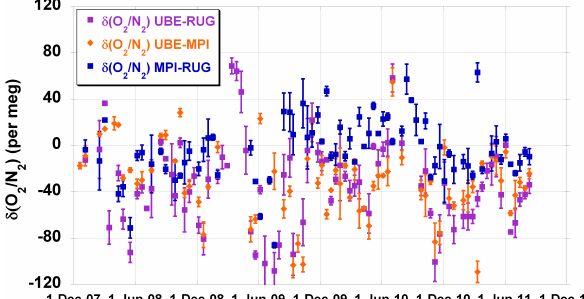
Fig. 4. δ (O 2 /N 2 ) observations from Jungfraujoch, Switzerland from flask samples measured by three laboratories: UBE (pink squares), RUG (orange diamonds) and MPI (blue circles). The values are the averages of 1, 2 or 3 flasks. The fits through the data are linear trends plus single harmonic seasonal components. Open symbols represent those values that are outliers to the fit of the individual data set (based on the 2.7 sigma exclusive filter on the residuals). The error bars represent the standard error of the average value of 2 or 3 flasks. For single flask measurements error bars are not shown.